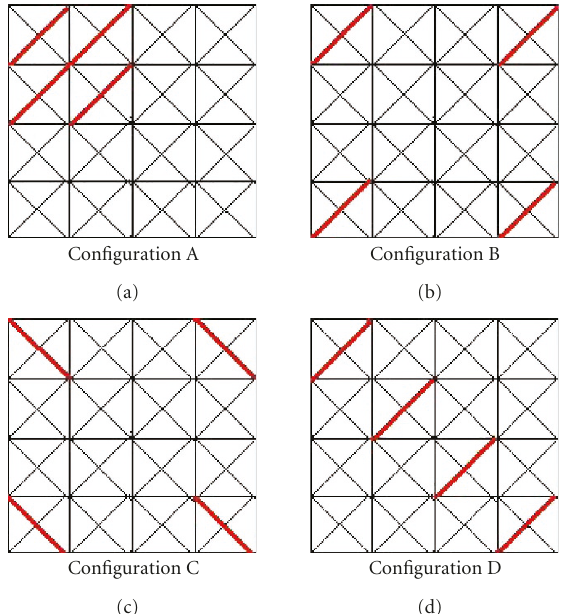
Figure 10: Chosen combinations of RX antenna elements. Four antenna elements can be chosen out of 16 dual-polarized ( ± 45 degrees) antenna